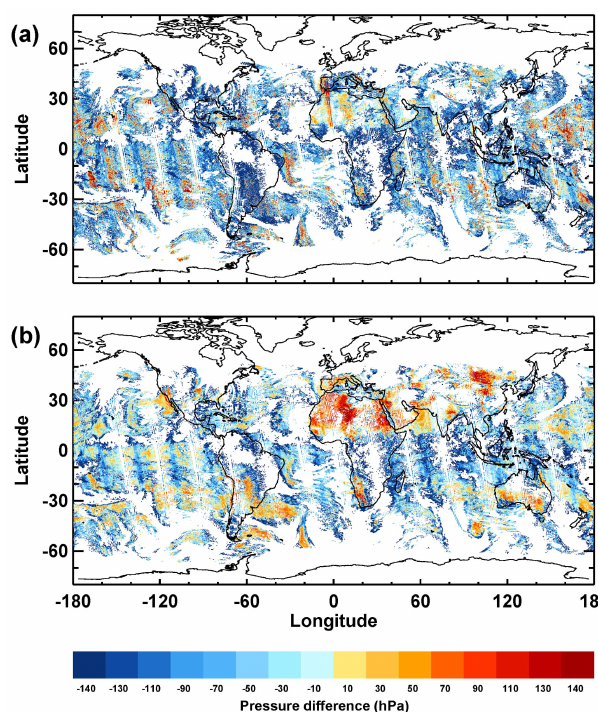
Figure 9. Difference between the scene pressure and the surface pressure, P sc − P s , for our algorithm (a) and OMCLDO2 v2 (b) . Data are for 13 November 2006.